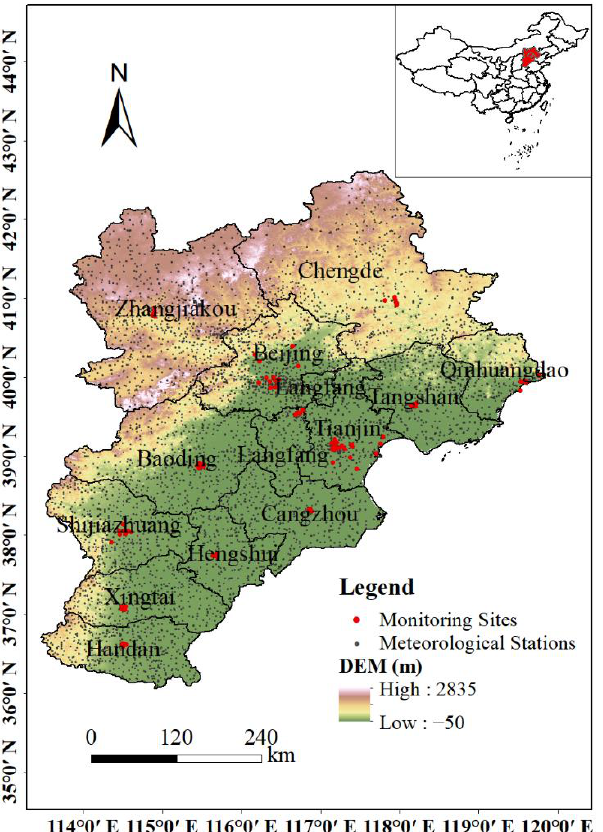
Figure 1. Distribution of O 3 monitoring sites, meteorological stations and topography in the BTH region.